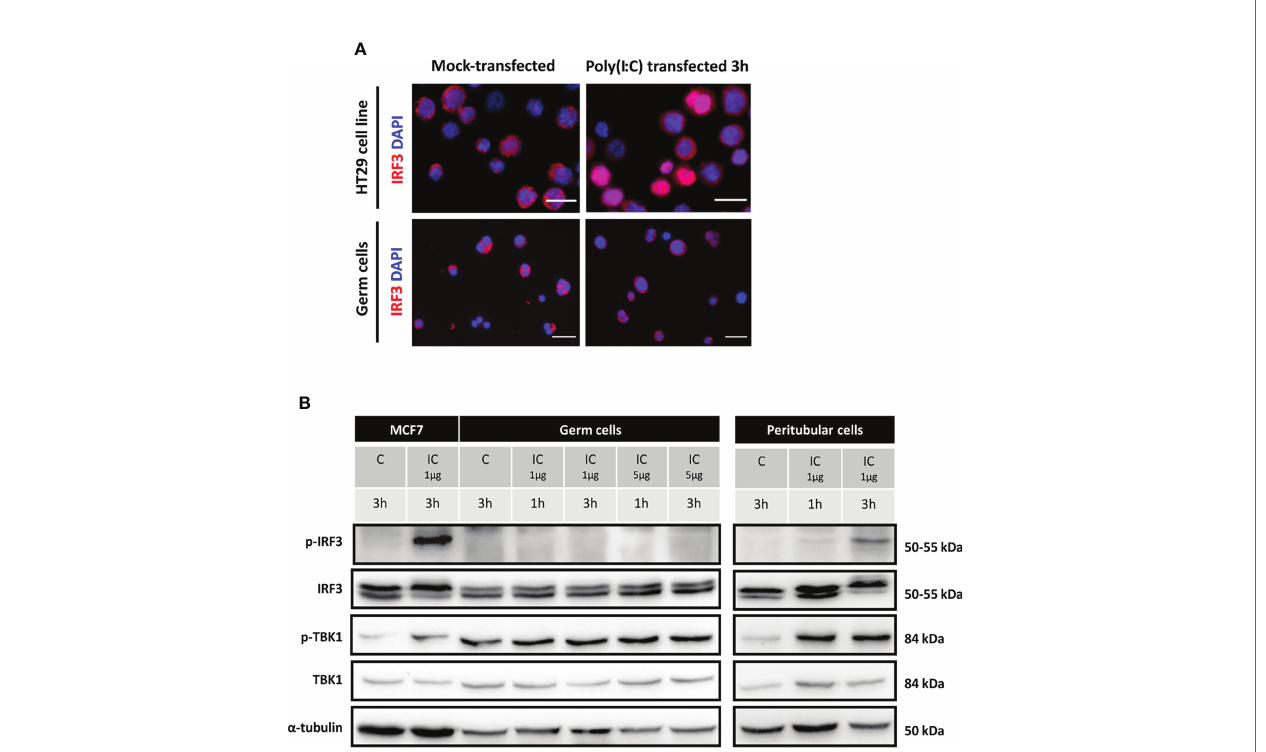
FIGURE 5 | IRF3 and TBK1 activation in human isolated testicular germ cells and peritubular cells exposed to Poly(I:C). Isolated human germ cells or peritubular cells were mocked-transfected (C) or transfected with 1 or 5 µg Poly(I:C) (IC) for the indicated duration. (A) The intracellular distribution of IRF3 in HT29 cells (positive control) and in isolated germ cells 3h post-transfection with Poly(I:C) was determined by indirect immuno fl uorescence staining. Mock-transfected cells served as controls. The images are representative of at least 3 experiments from different donors. White scale bars: 20µm. (B) The phosphorylation of IRF3 and TBK1, as well as total IRF3 and TBK1 levels, was determined in testicular germ cells and peritubular cells by Western-blot analysis. Each lane corresponds to 40µg of protein lysate. MCF7 cells lysates were included as controls. a -tubulin was used as the loading